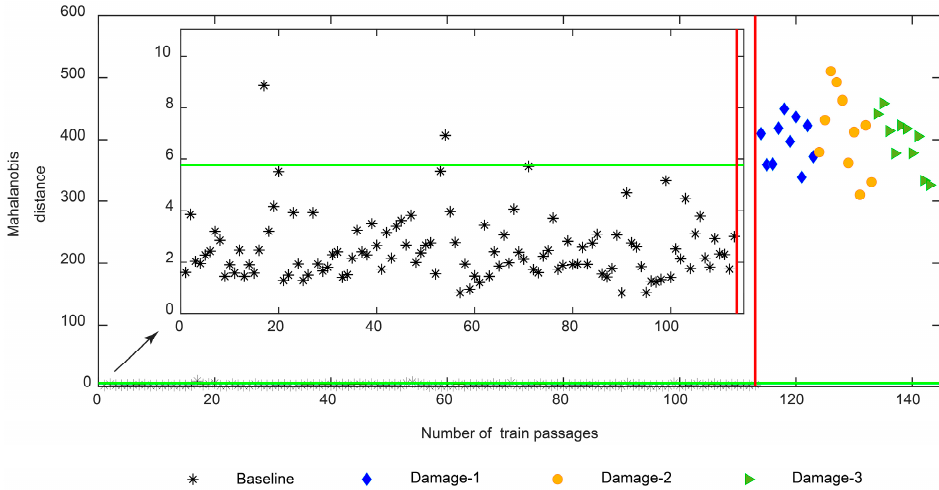
Figure 24. PCA—automatic wheel flat damage detection considering the multi-sensor data fusion.